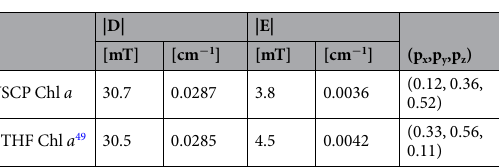
Table 1. ZFS parameters and zero-field population probabilities (p x, y, z ) of the 3 Chl used in simulations of the TR-EPR spectrum. Other parameters: linewidth = 2 mT, g iso =